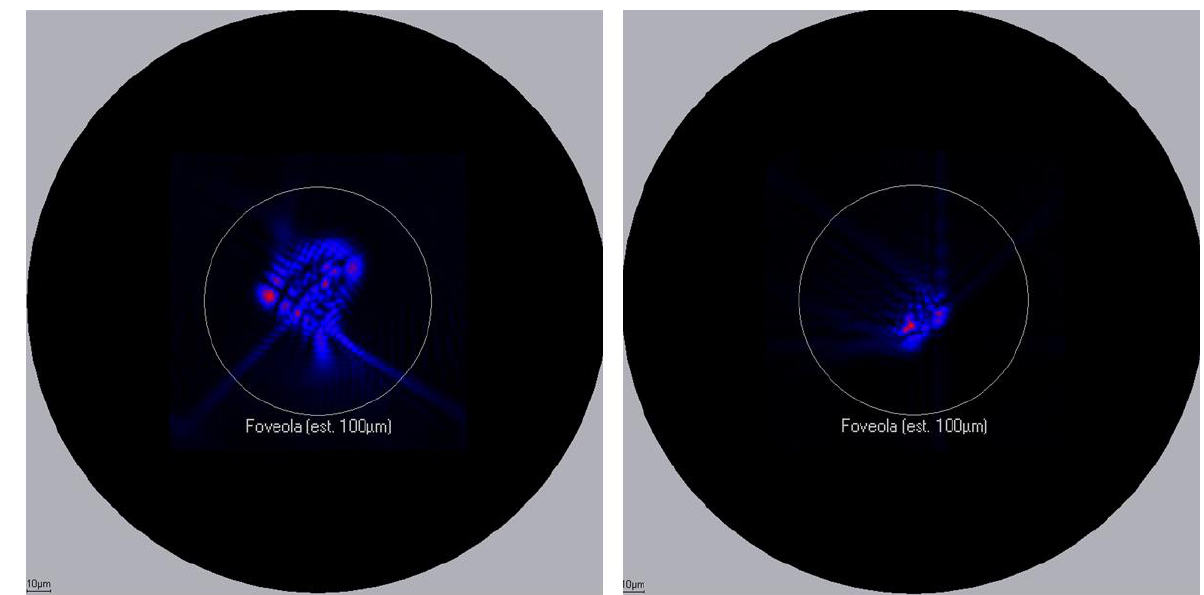
Figure 2. Reduction of PSF after wavefront-guided presbyLASIK.